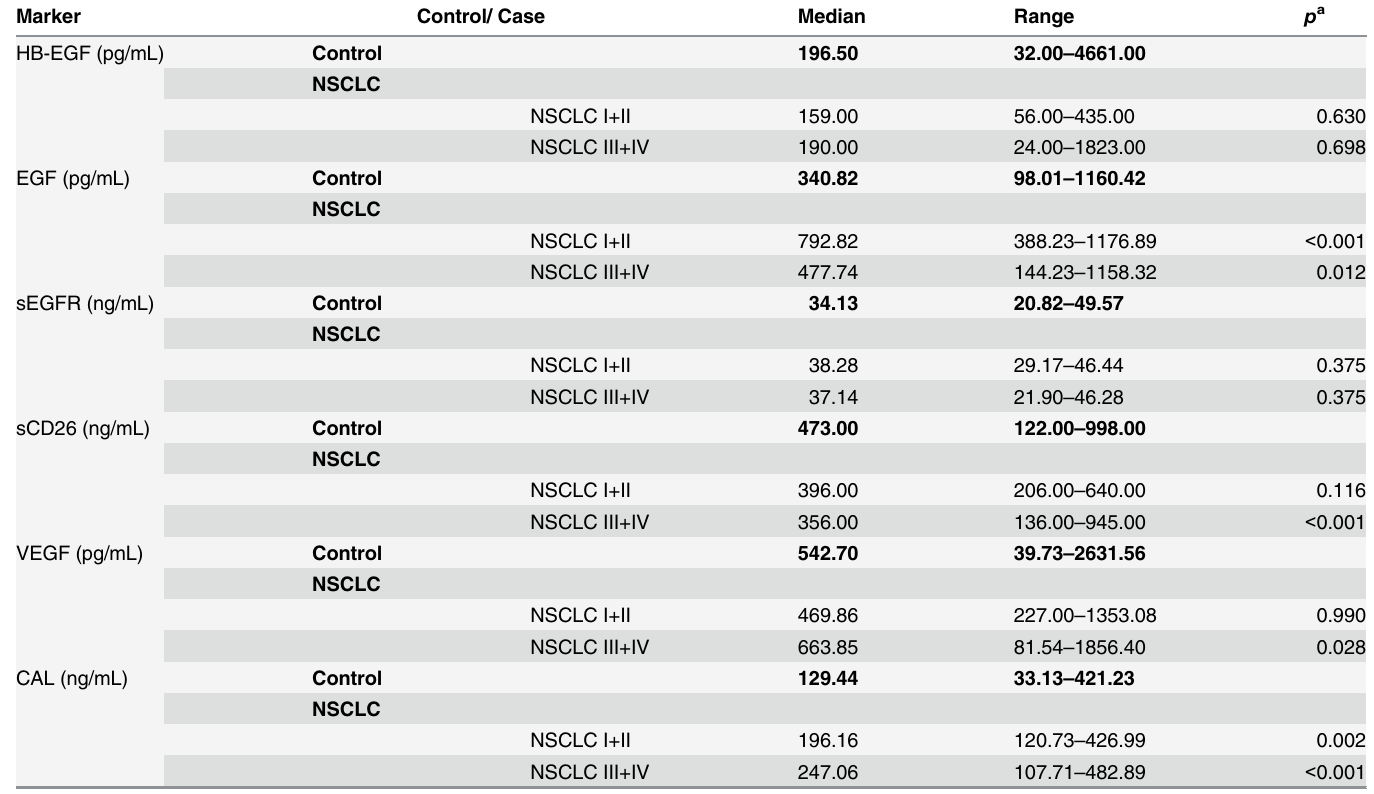
Table 2. Distribution of markers in early and advanced NSCLC versus